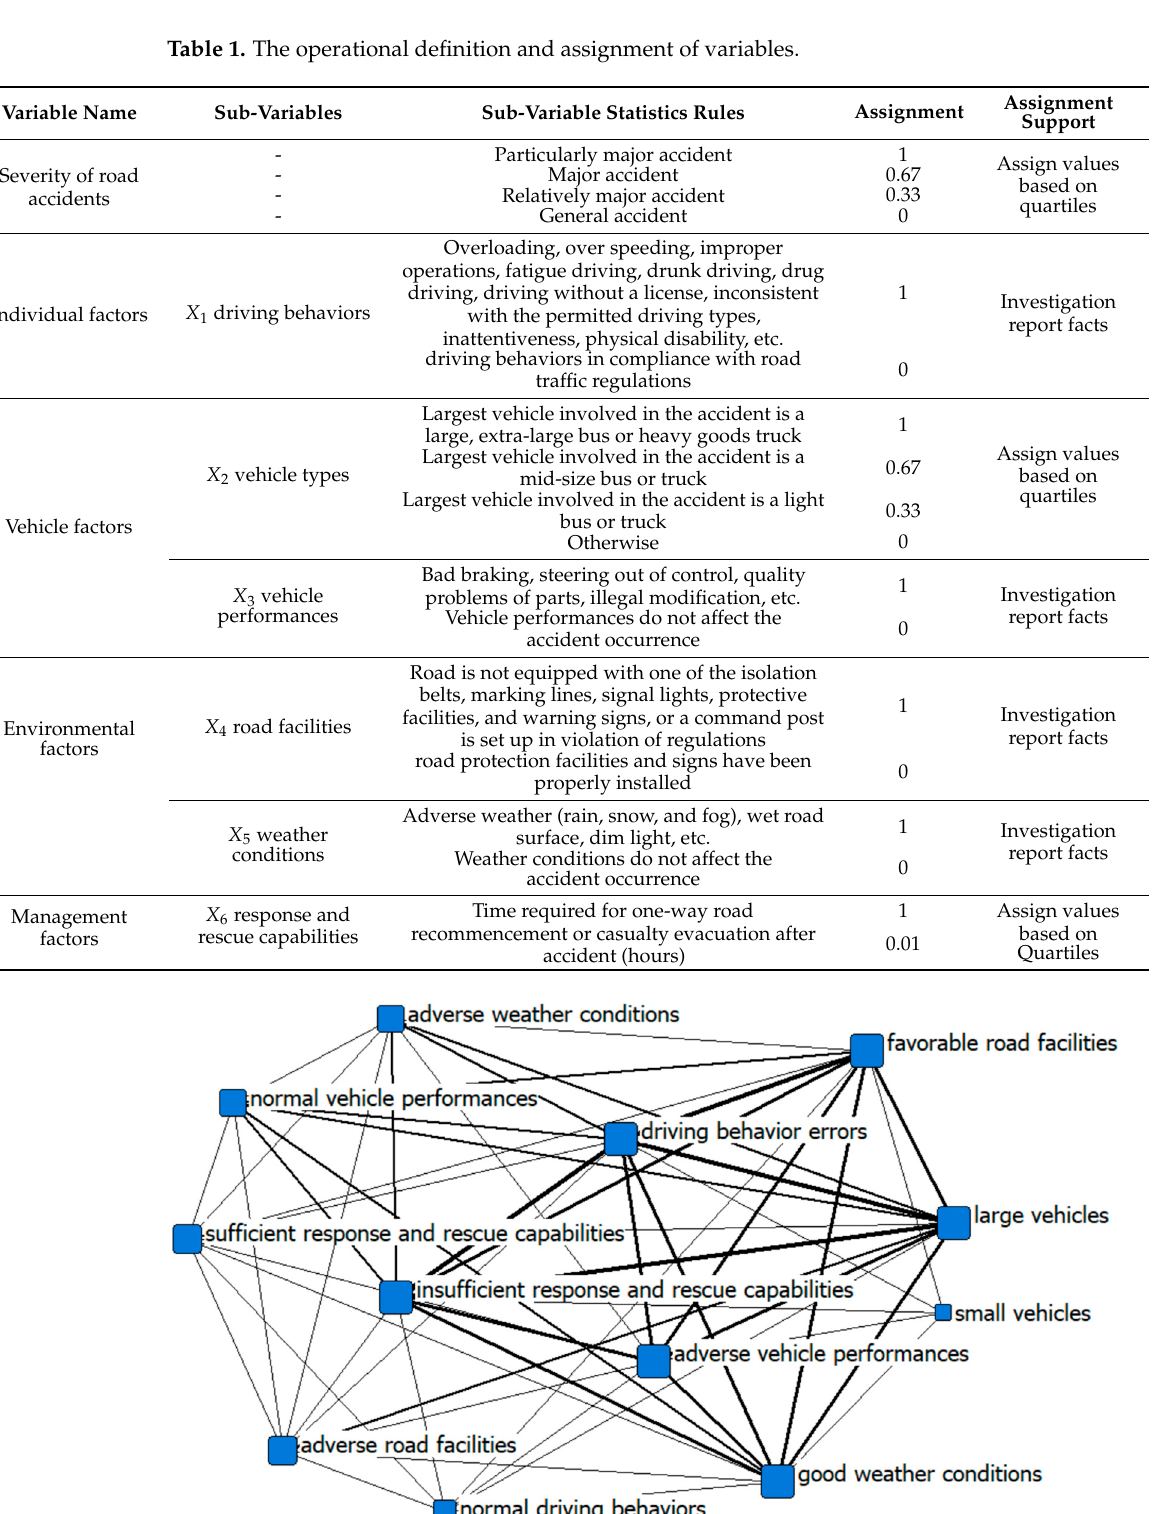
Figure 3. The social network analysis of general road accidents. In order to further quantify the difference between the two, the frequency of cases is set to one, the consistency threshold is set to 0.8, and the PRI consistency threshold is set to 0.7 [28]. The single factor necessity and sufficiency are further calculated to measure the importance of condition variables. 3. Empirical Analysis 3.1. Single Factor Necessity and Sufficiency Analysis The single factor necessity and sufficiency analysis are performed using fsQCA3.0 software. The corresponding computation results are presented in Table 2. In the necessity test, the consistency of a condition variable is greater than 0.9, which is a necessary condi- tion for the outcome variables [32]. When the consistency of a condition variable is in the interval [0.8,0.9], which is the sufficient condition of the outcome variables [33]. Based on this, driving behavior errors and large vehicles are necessary conditions for major road accidents. Driving behavior errors are a necessary condition for general and relatively major road accidents, and large vehicles and favorable road facilities are sufficient